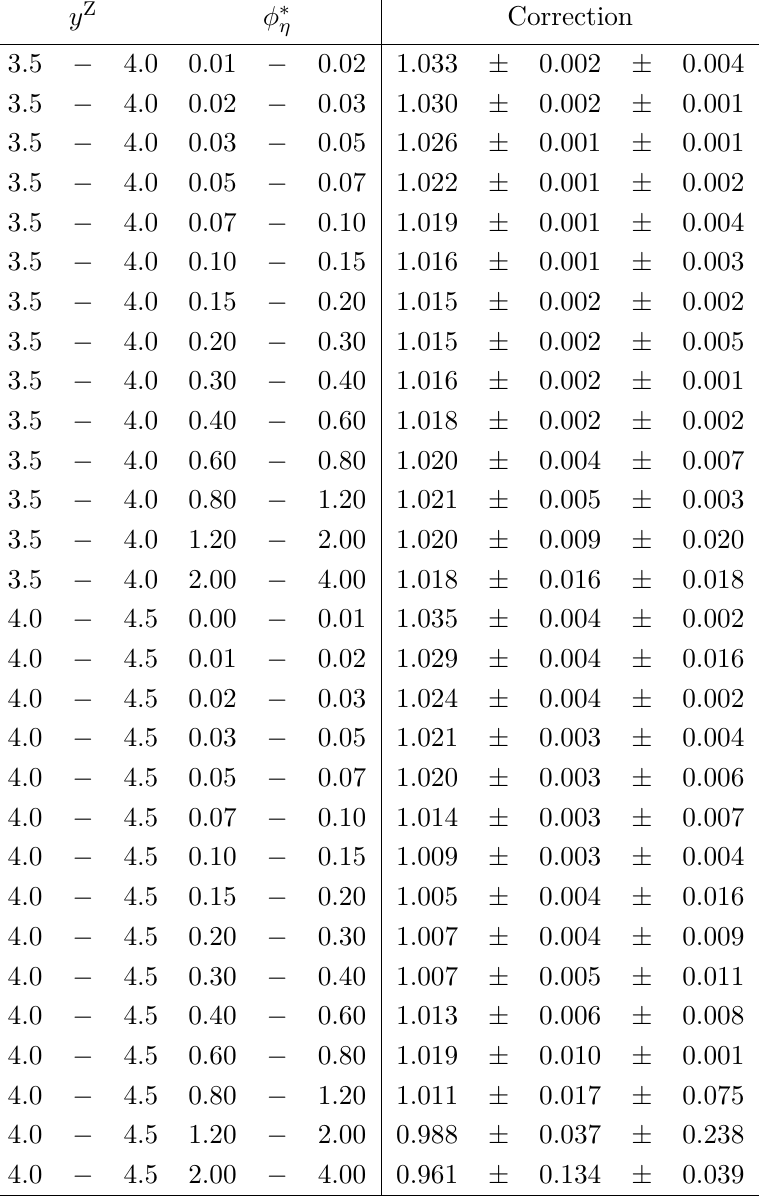
Table 6. Final state radiation correction used in the y Z − φ ∗ The first uncertainty is statistical and the second is